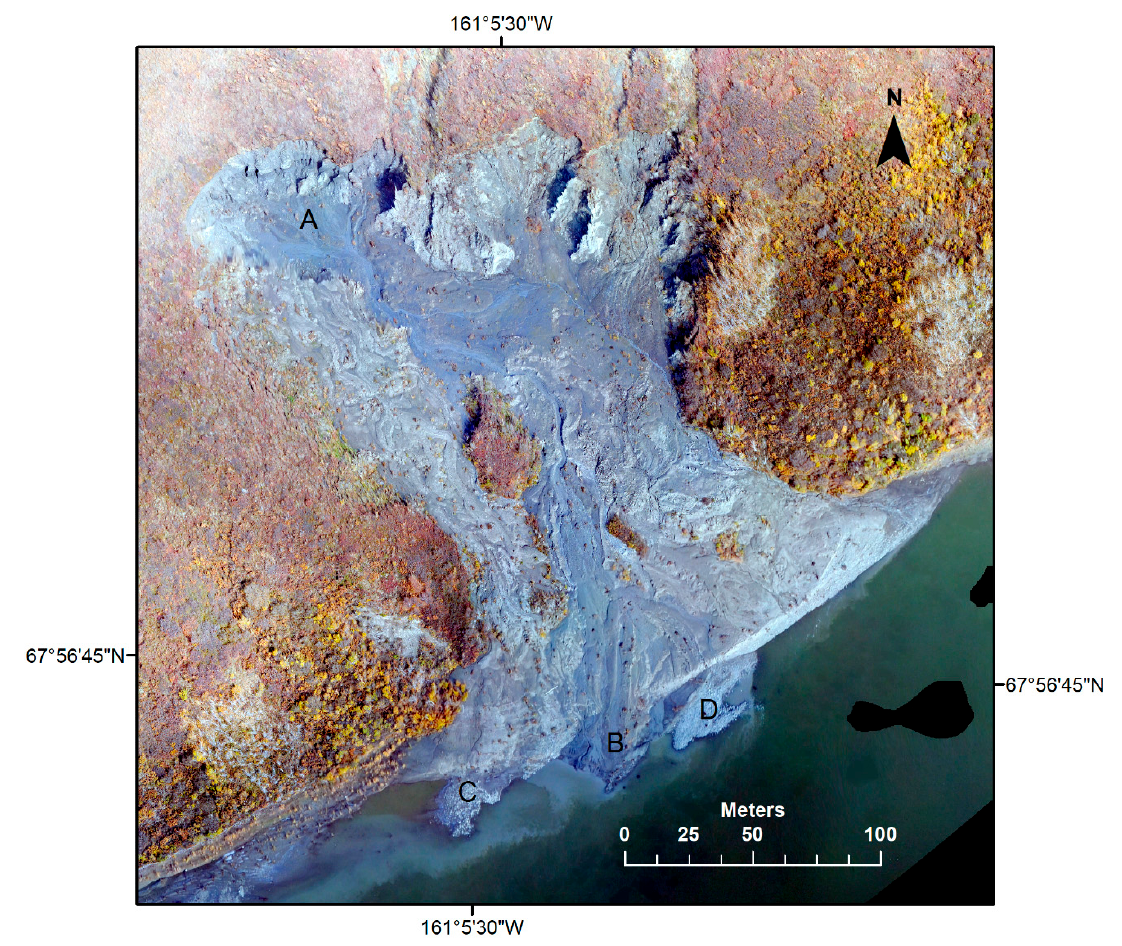
Figure 17. Orthophotograph of slump NOAT265 from photographs taken on 11 September 2012.